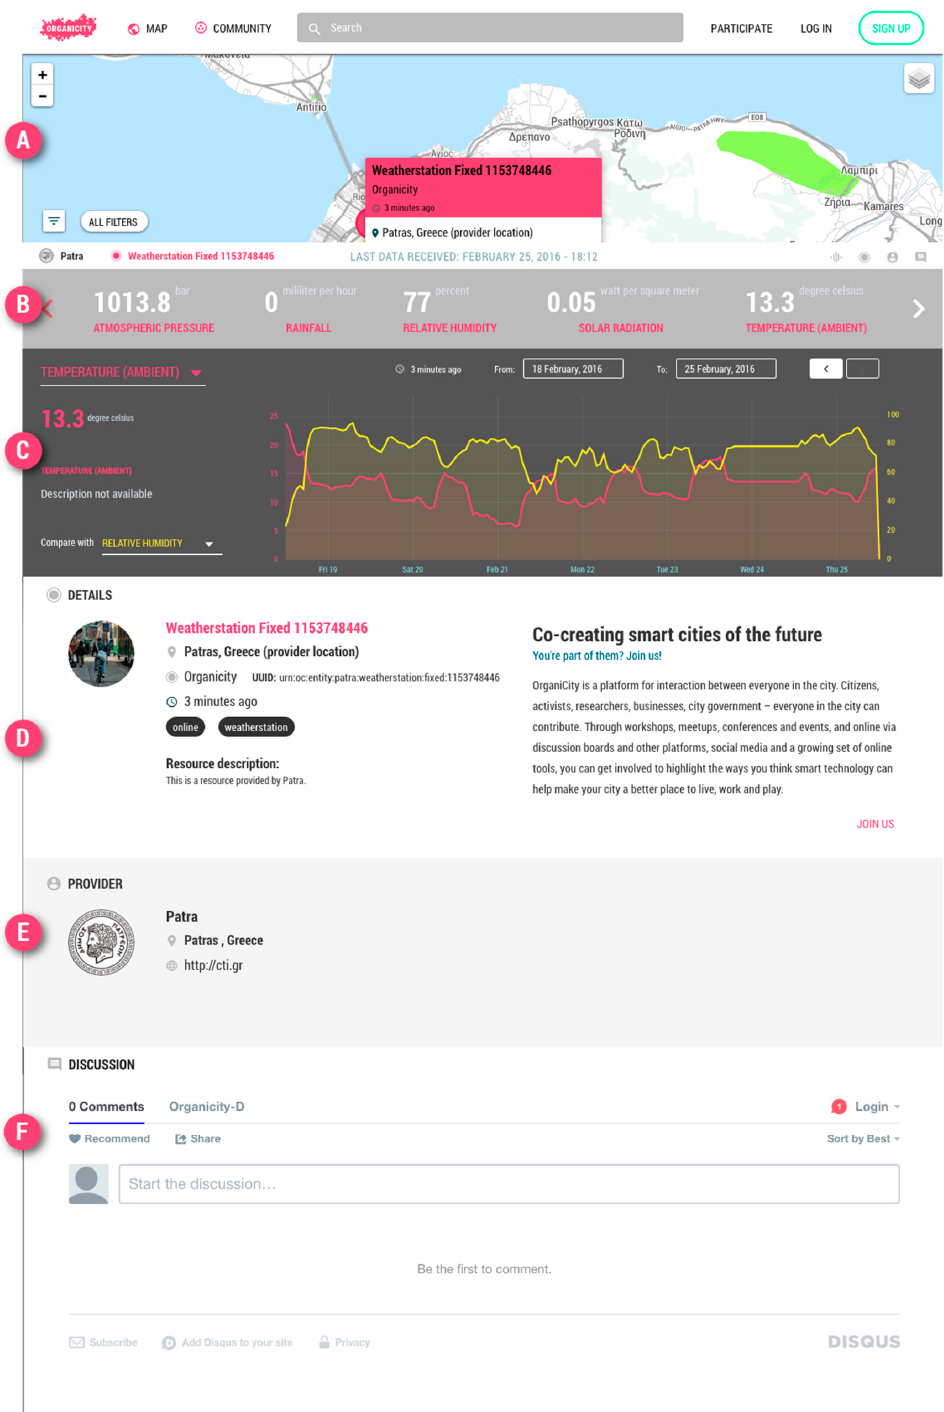
Figure 7. Assets visualization within the UDO UI: ( A ) Data Location; ( B , C ) Data Visualization; ( D ) Assets details and metadata; ( E ) Provider details; ( F ) Comments.